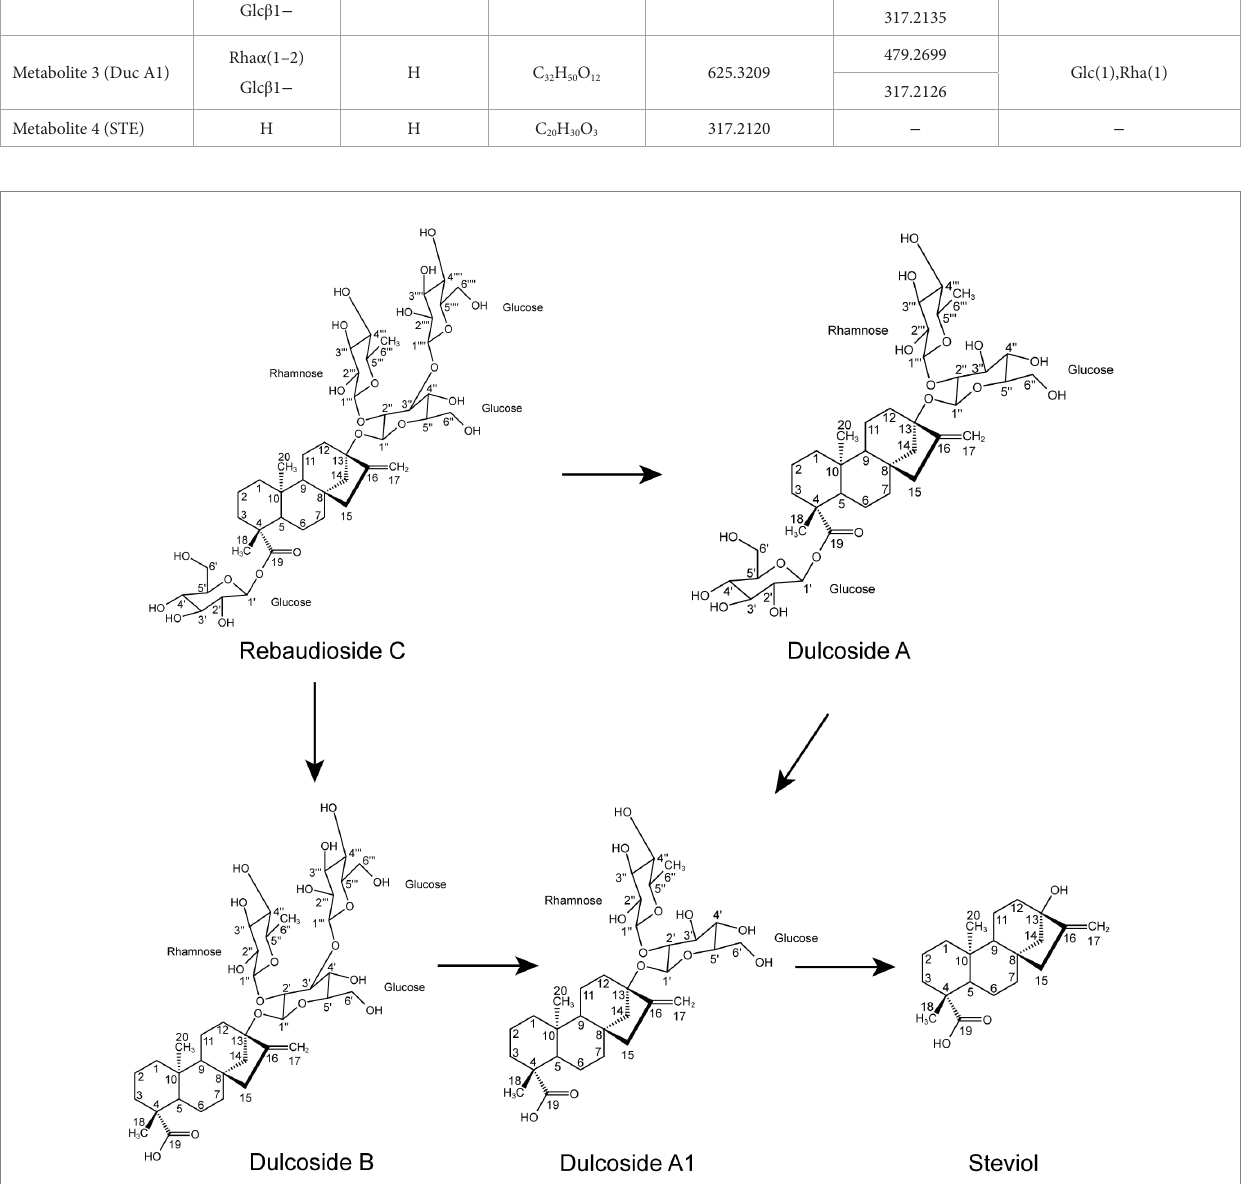
FIGURE 3 Proposed hydrolysis pathways of RC in P. ilicis